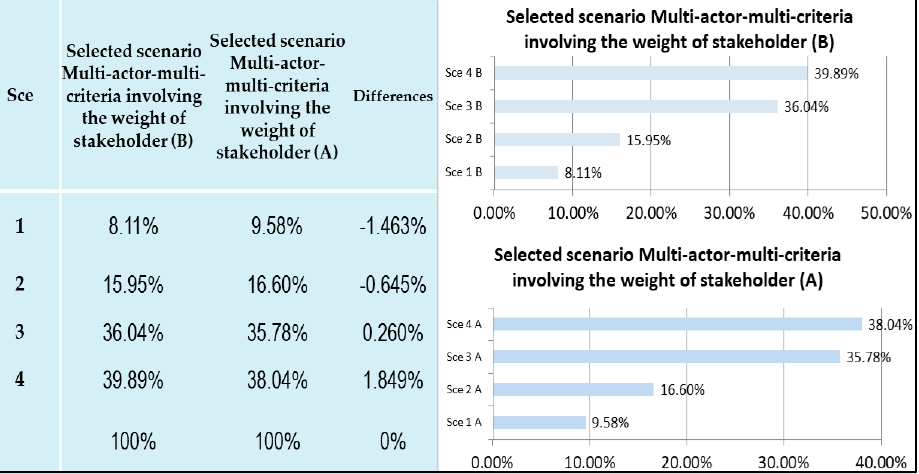
Figure 12. Differences in scenario 4 between multi-actor multi-criteria analysis (method A) and multi-actor multi-criteria analysis with the weight of stakeholder involvement (method B).